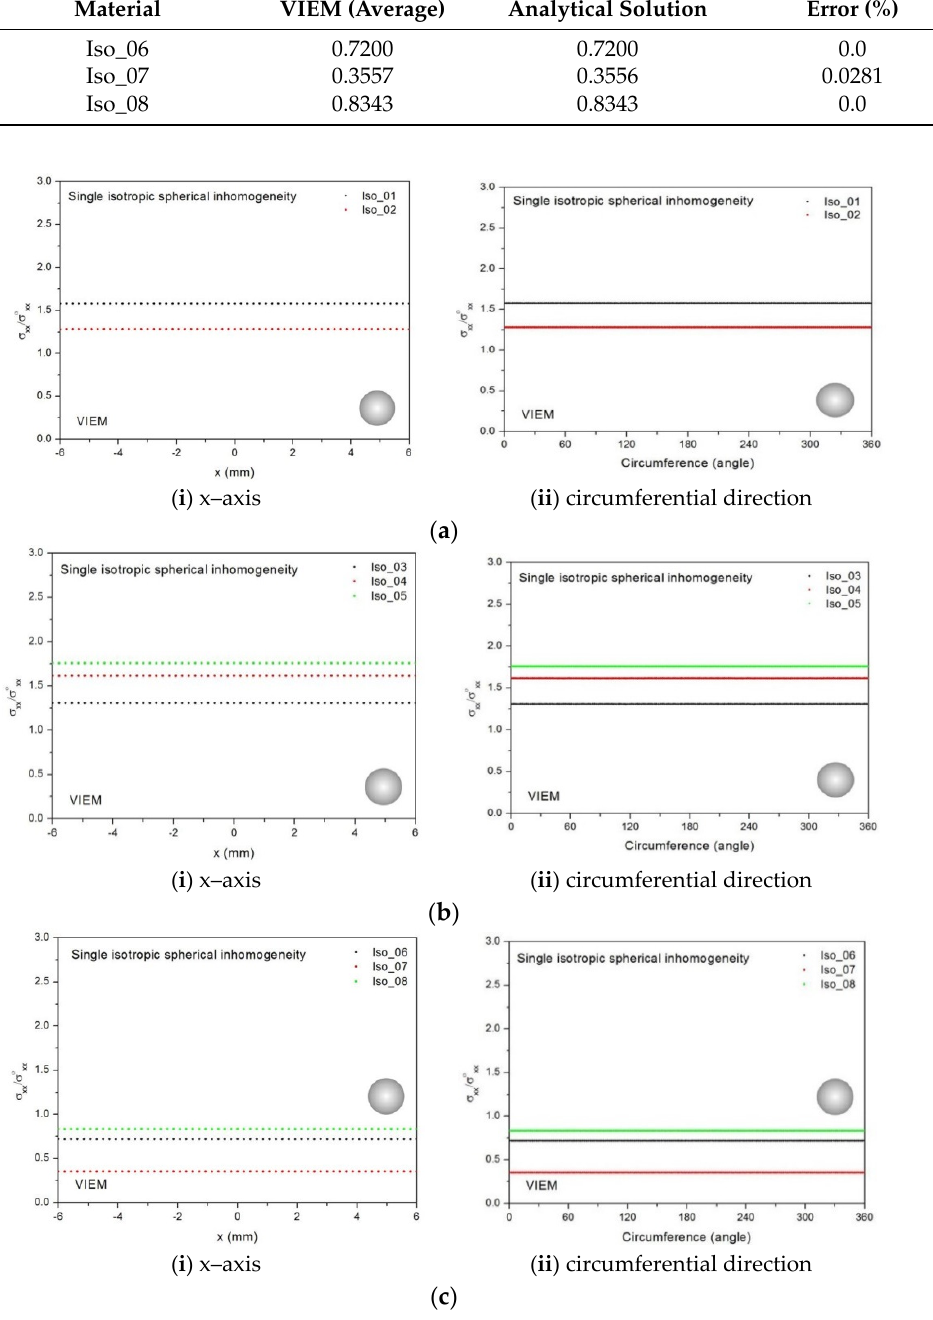
Figure 8. VIEM results for the normalized tensile stress component ( σ xx / σ oxx ) along ( i ) the x–axis inside and ( ii ) the circumferential direction of the isotropic spherical inclusions with a radius of 6 mm under uniform remote tensile loading. ( a ) Iso_01 and Iso_02. ( b ) Iso_03, Iso_04 and Iso_05. ( c ) Iso_06, Iso_07 and Iso_08.